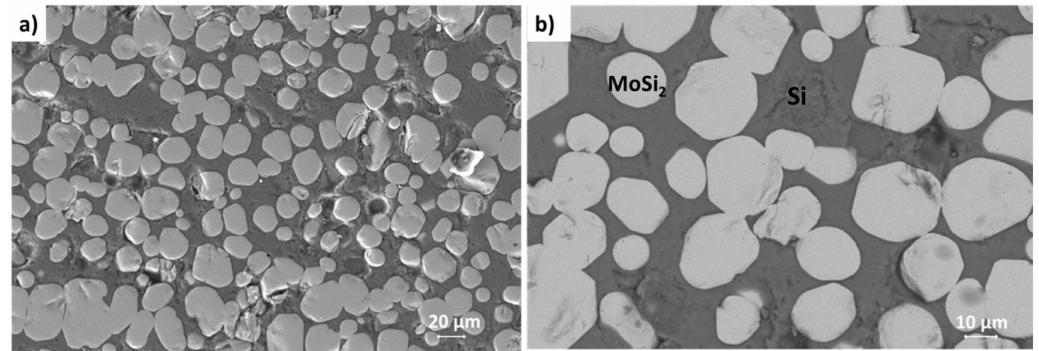
Figure 9. Microstructure of the MoSi 2 /Si joining material; it is an in-situ formed composites/MoSi 2 particles embedded in a Si matrix), ( a ) cross-section of the joining material; ( b ) higher magnification micrograph: MoSi 2 particles are round shaped and their size (diameter) ranges from 10 to 40 µ